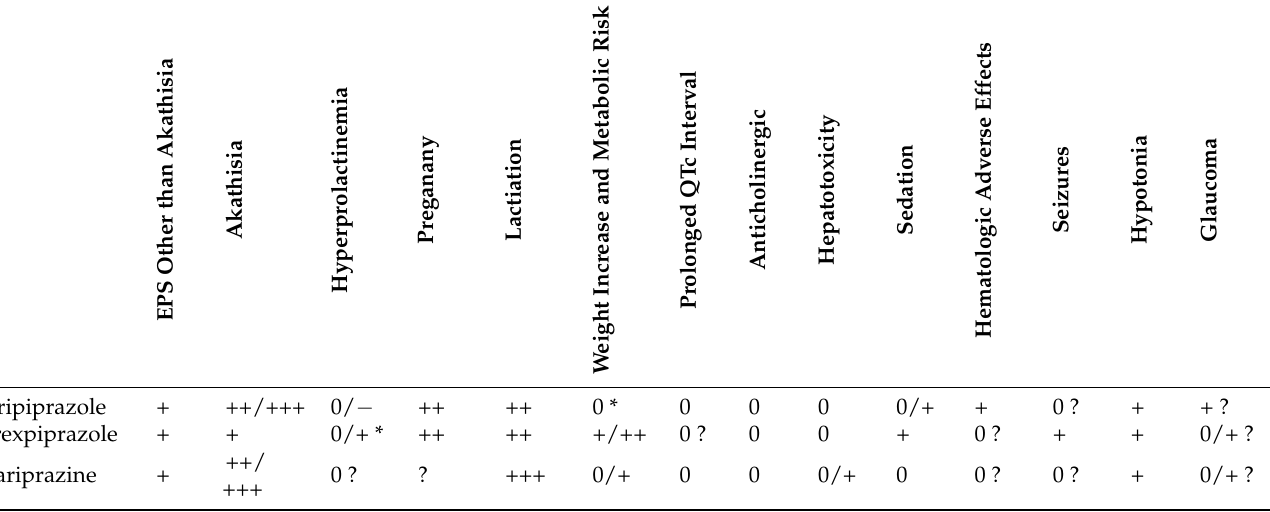
Table 7. The data on the adverse events of brexpiprazole vs. aripiprazole and